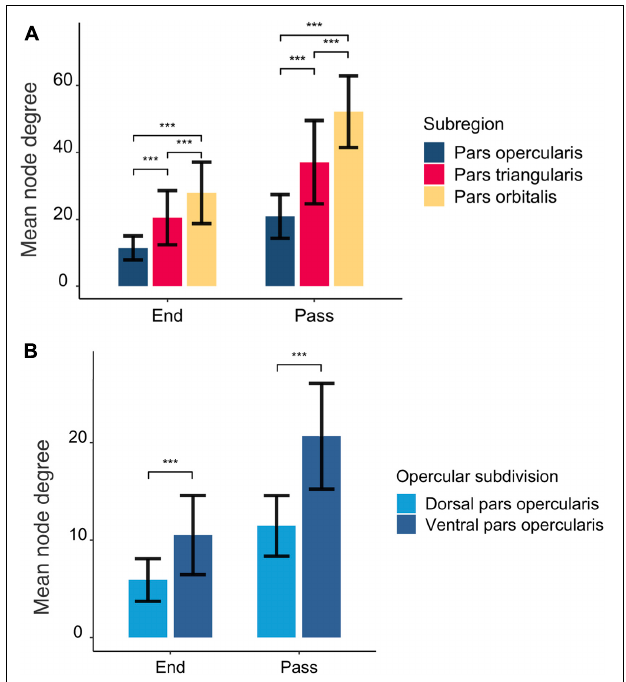
FIGURE 2 | The mean number of interconnected regions seeding from the rIFG subregions (A) and opercular subdivisions (B) . End and pass represent whether the tracts were part of an ending or passing fiber pathway. The error bars represent standard deviations. The asterisks above the bars mark statistical significance level at p <